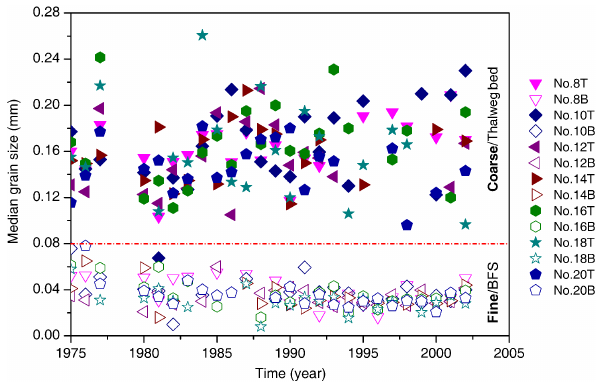
Figure 3. The median sizes of the thalweg bed sediments and the bar or floodplain surface sediments (BFS) in the Ulan Buh desert braided channel from 1975 to